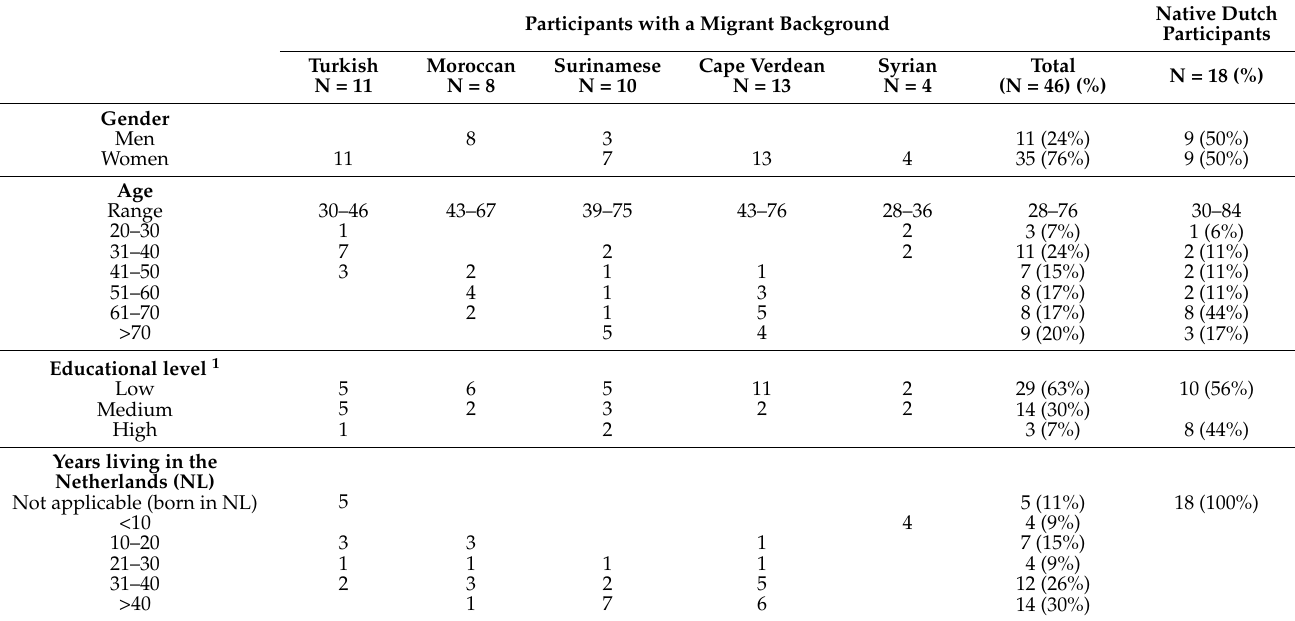
Table 1. Background characteristics of participants of the focus group discussions (N =